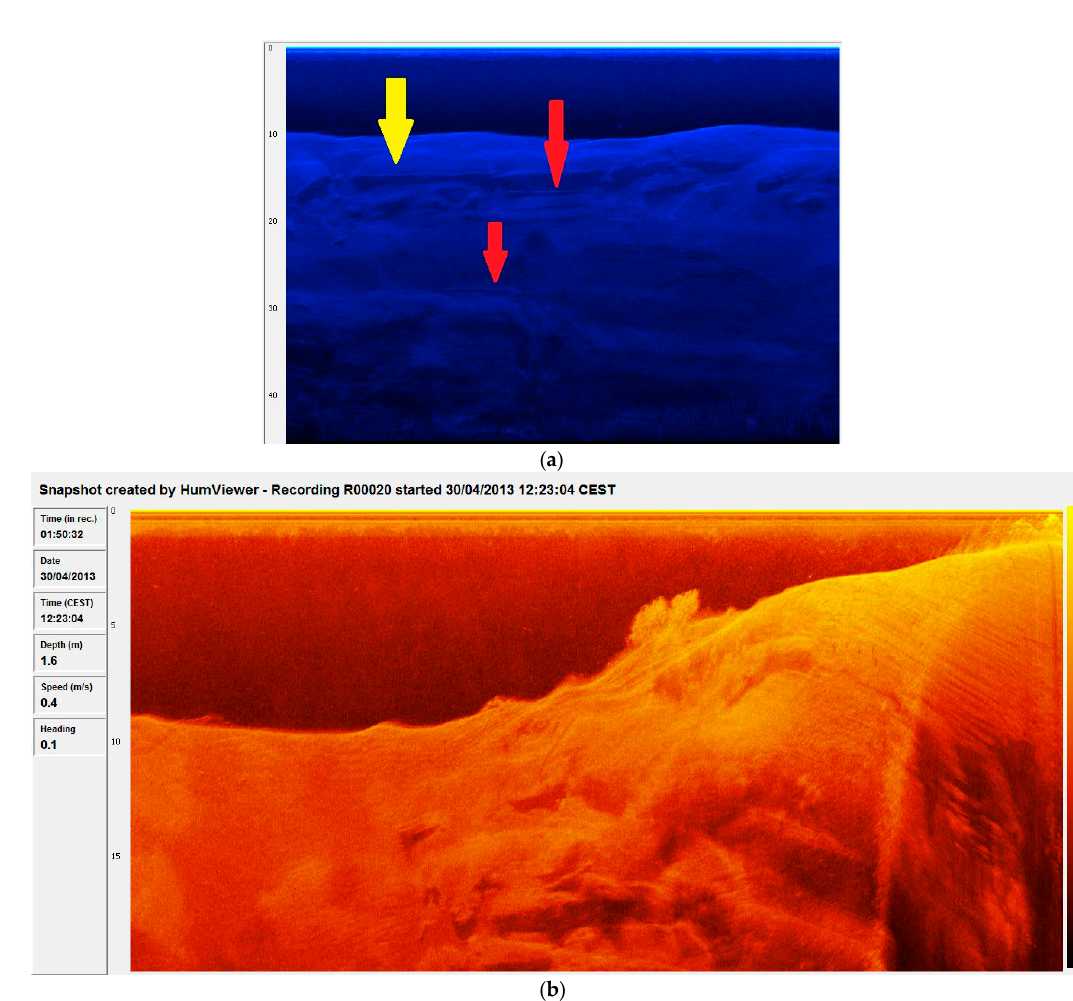
Figure 6. Visualization of the echo side scan sonar snap shots with Hum viewer software, in Lago Tramonto, Gambulaga, Portomaggiore (FE, Italy): ( a ) Down image of the northern, ancient riverside (indicated by yellow arrow) with fallen posts (red arrows); ( b ) Down image of mudslide and collapsed structures.